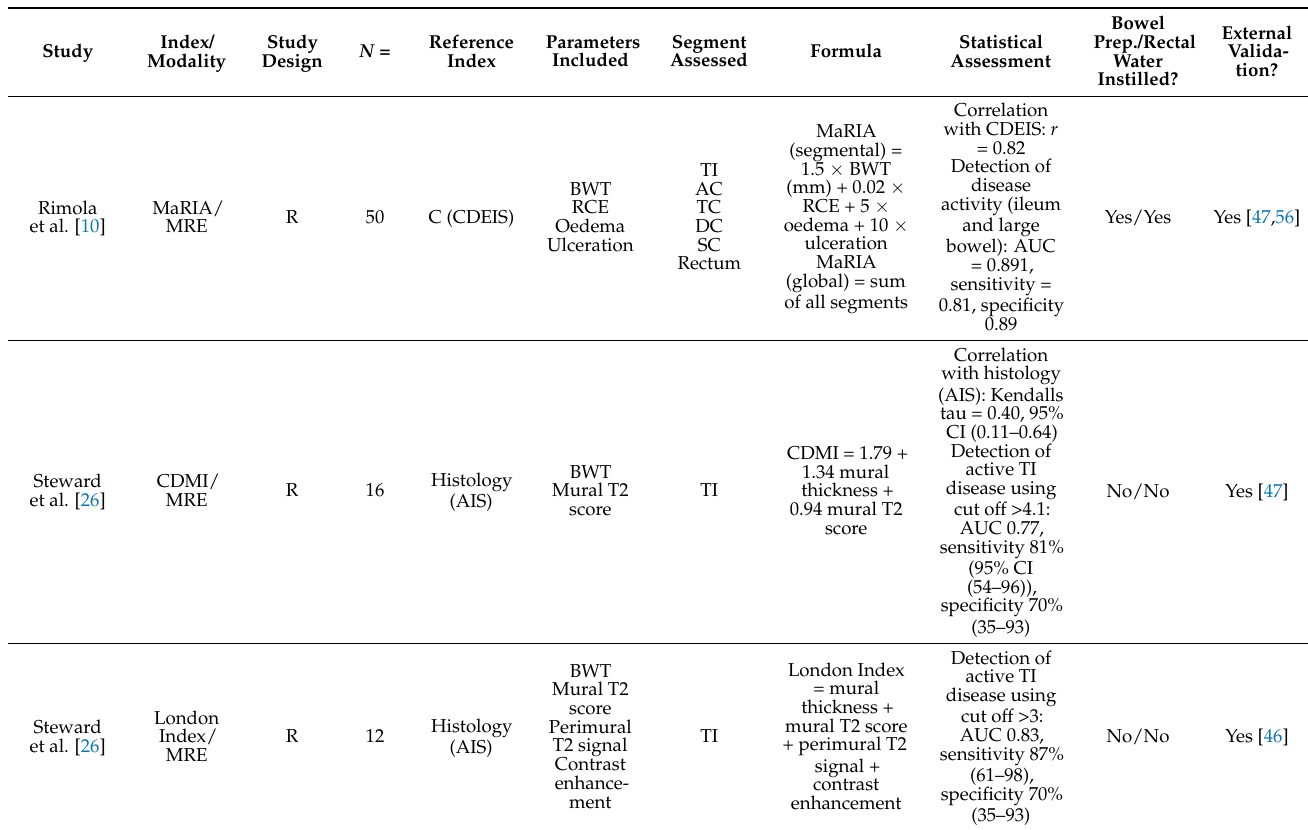
Table 2. Summary of cross-sectional modality indices of activity in